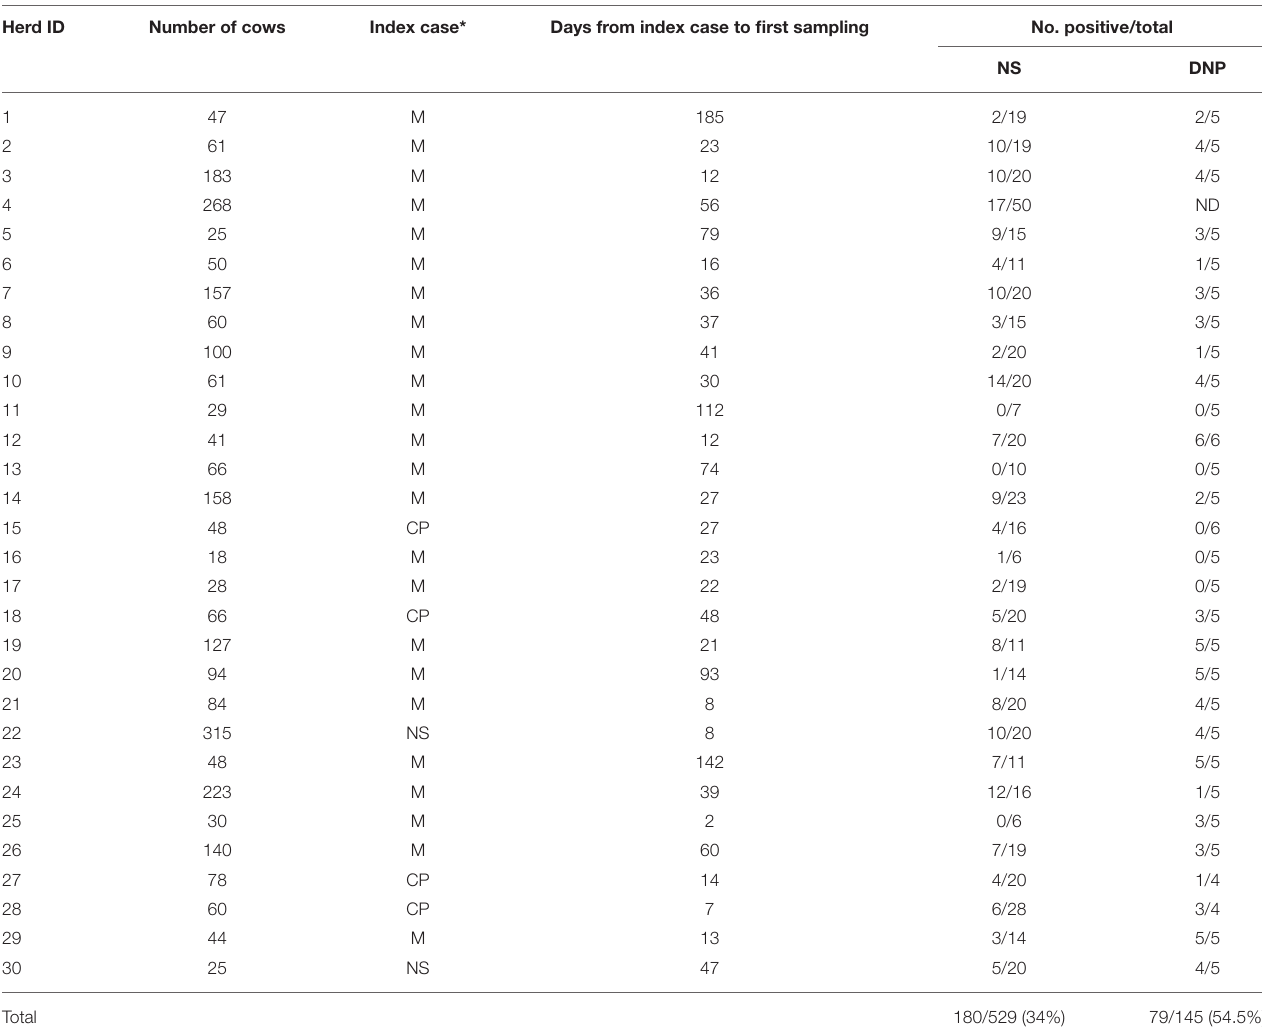
TABLE 4 | M. bovis detected in nasal (NS) and deep nasopharyngeal (NP) swabs in 30 dairy farms during the first visit after the index case. Herd ID Number of cows Index